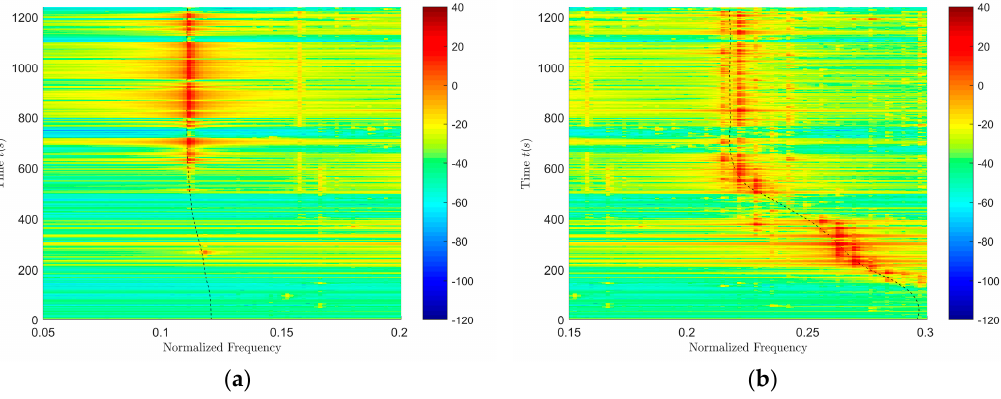
Figure 10. The normalized spectrum of v z signal in the band where the first two line spectrums locate and its frequency sequence extraction results. ( a ) The first line spectrum and its frequency sequence extraction results; ( b ) The second line spectrum and its frequency sequence extraction results.